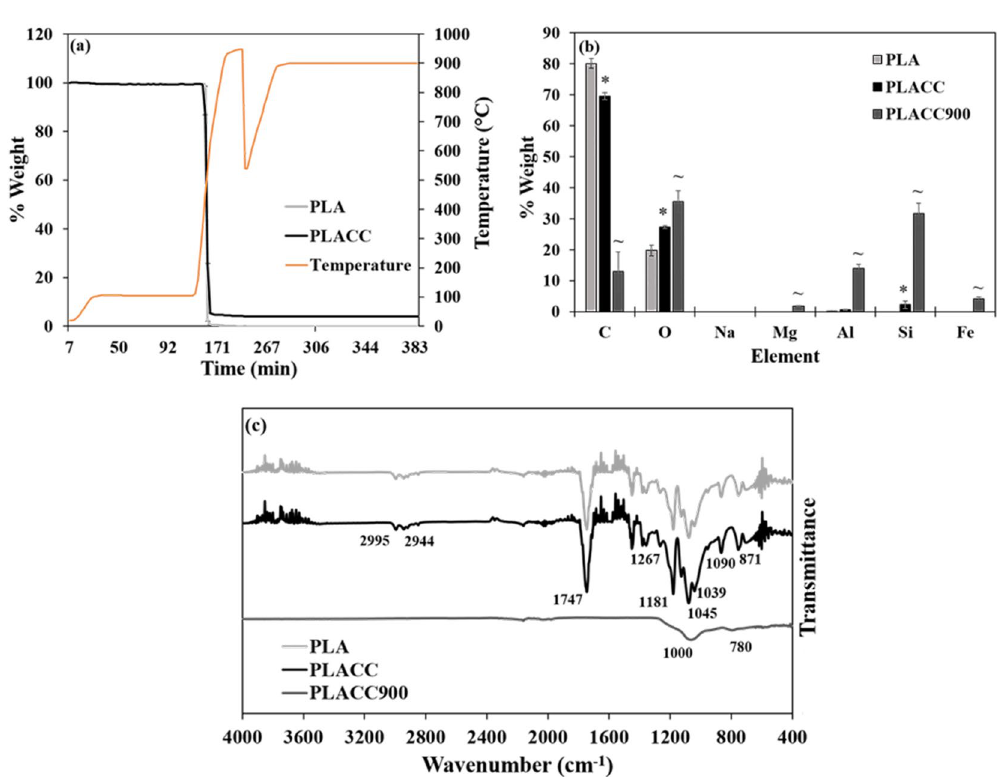
Figure 1. ( a ) Thermal degradation profile of PLA and PLACC as determined by TGA (n = 2). Chemical characteristics analysis. (b ) Elemental composition of PLA, PLACC, and PLACC900 as determined by EDX (n = 5; taken from 5 different areas on the sample). The symbol * and ~ indicate significant differences between PLA and PLACC and between PLACC and its incinerated byproduct, PLACC900, respectively. ( c ) FTIR spectra for PLA, PLACC, and PLACC900 (n =